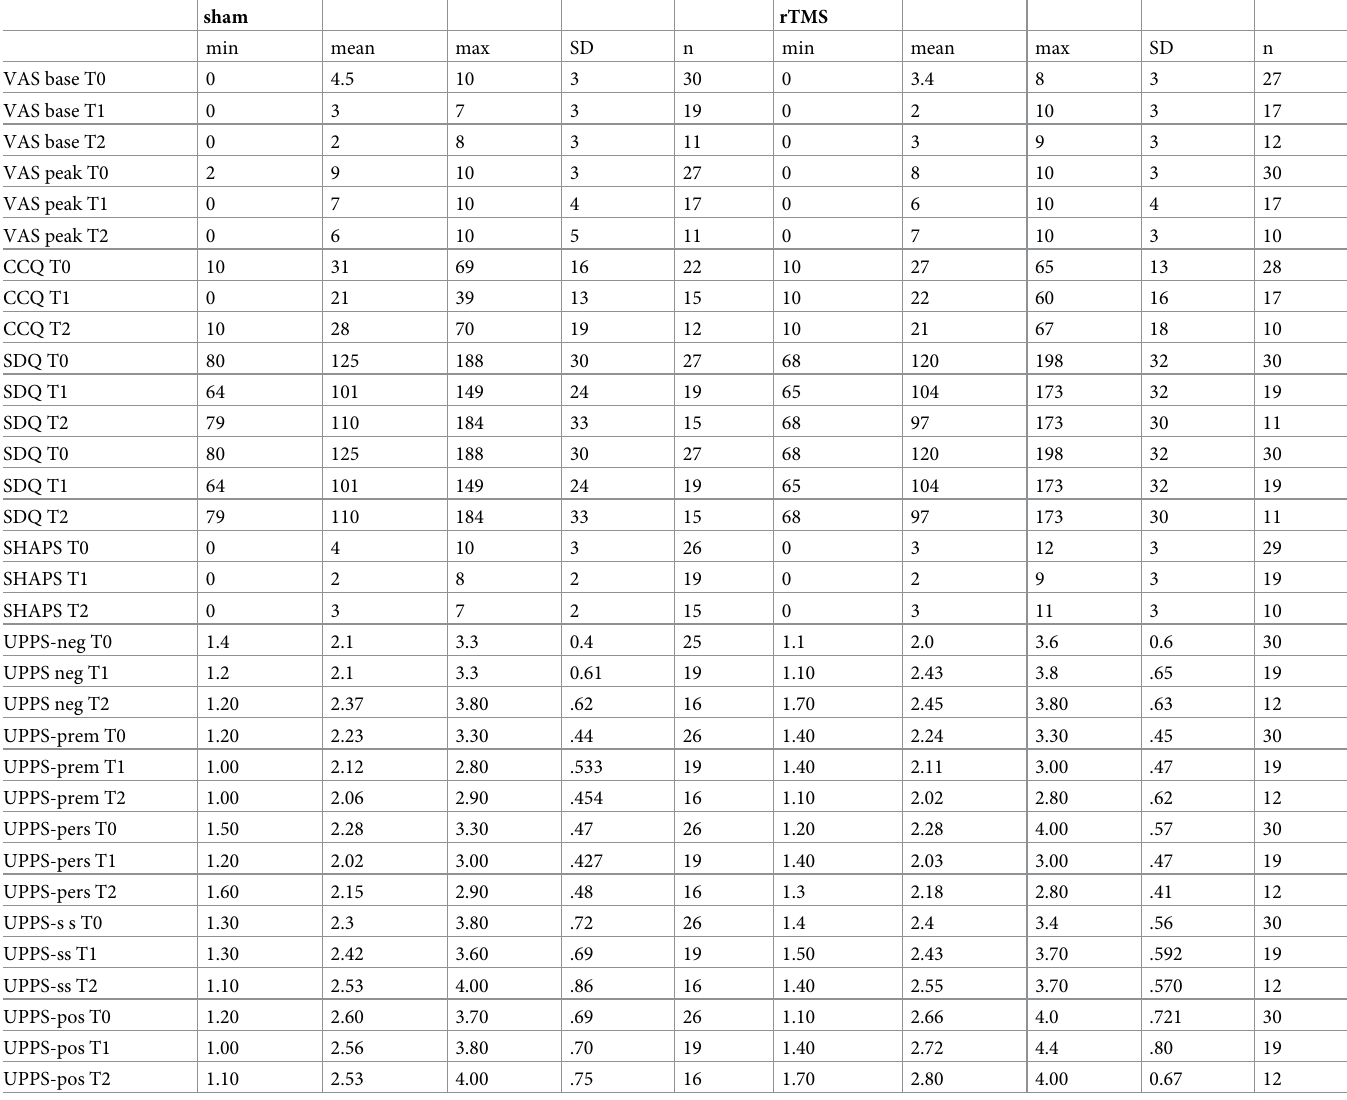
Table 2. Patients’ data after